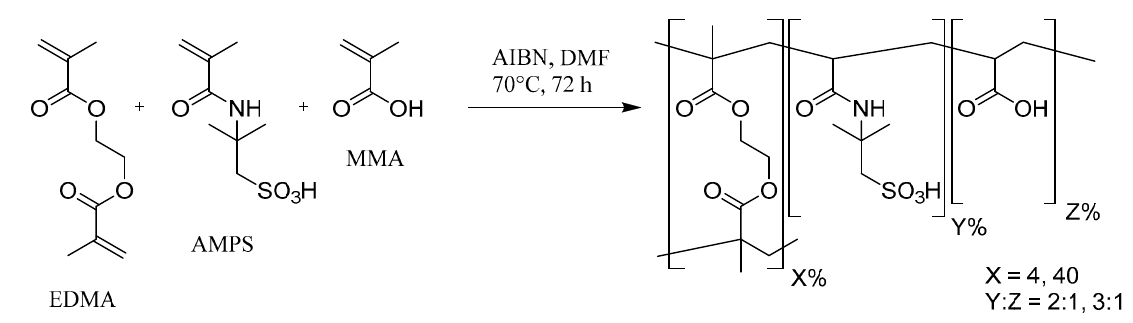
Figure 1. Chemical structure of the AHE copolymers.